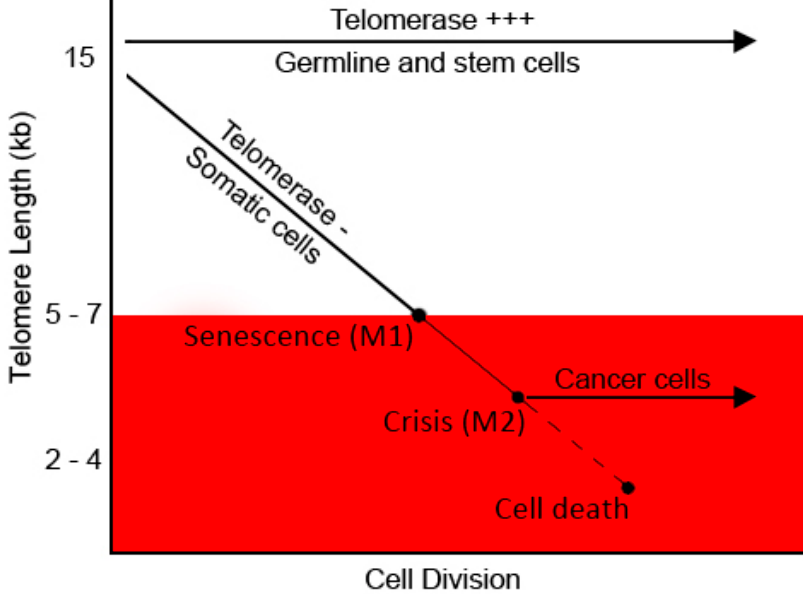
Figure 2. Telomere length and cellular ageing. Telomere shortening-mediated cell arrest occurs in somatic cells proliferating for a few cycles (M1). Non-arrested cells undergo progressive telomere shortening and die by apoptosis at M2. Cells that have a mutated apoptotic checkpoint encounter death due to massive genomic instability. Modified from [123].